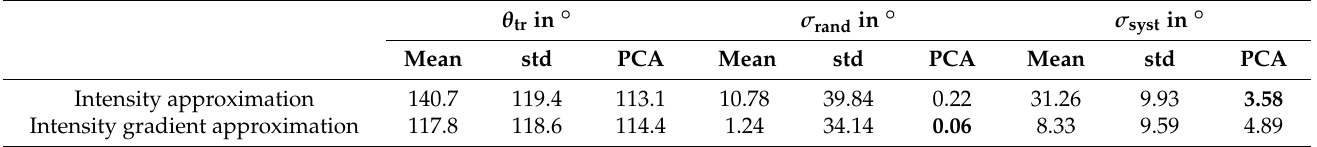
Table 1. Located flow transition position θ tr and corresponding random and systematic error σ rand and σ syst by means of both localizations methods for each image processing methods’ resulting flow visualization in the cylinder object experiment at a Re = 5.1 × 10 5 . Temporal mean value (mean), temporal standard deviation (std) and PCA. All values are normalized to the angular position [0°,180°] on the